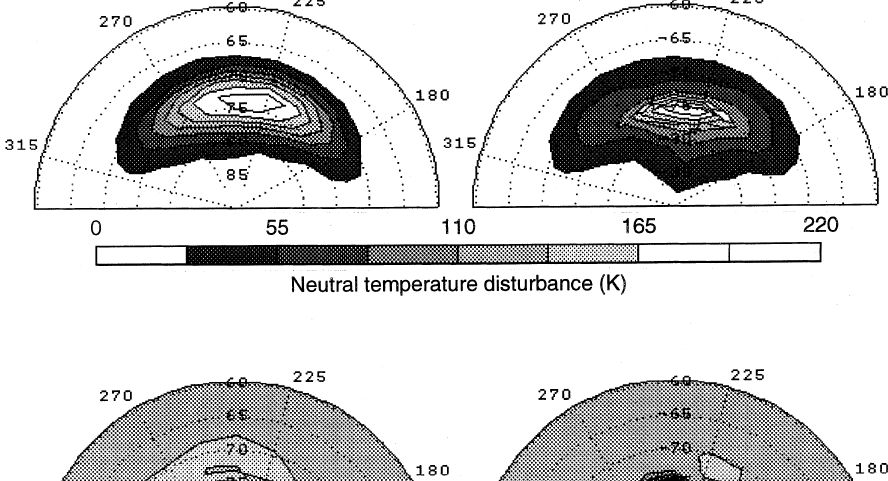
(winter, right plot ) Hemispheres at 0040 UT which is the time of maximum of the thermospheric disturbances. The Sun position is at the